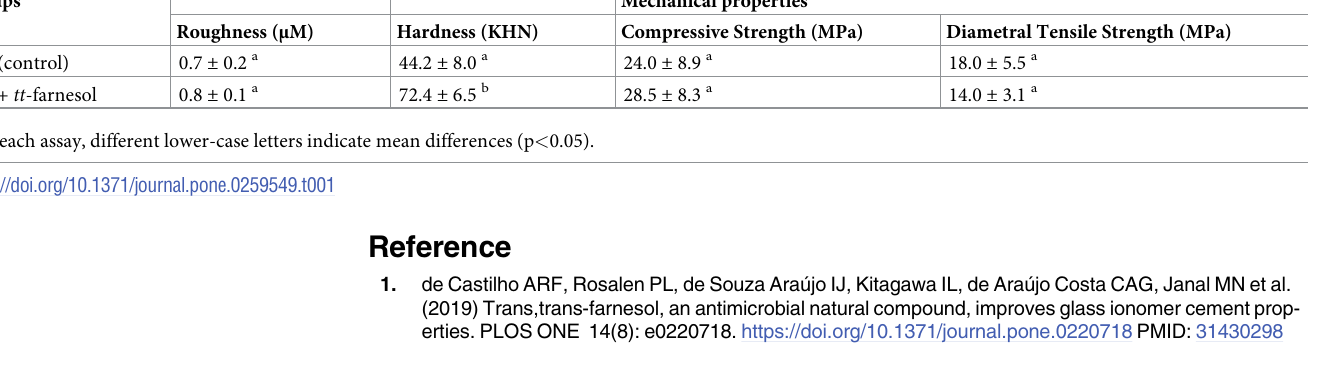
Table 2. Roughness, hardness, compressive and diametral tensile strength of GIC containing or not tt -farnesol (mean ± standard deviation).